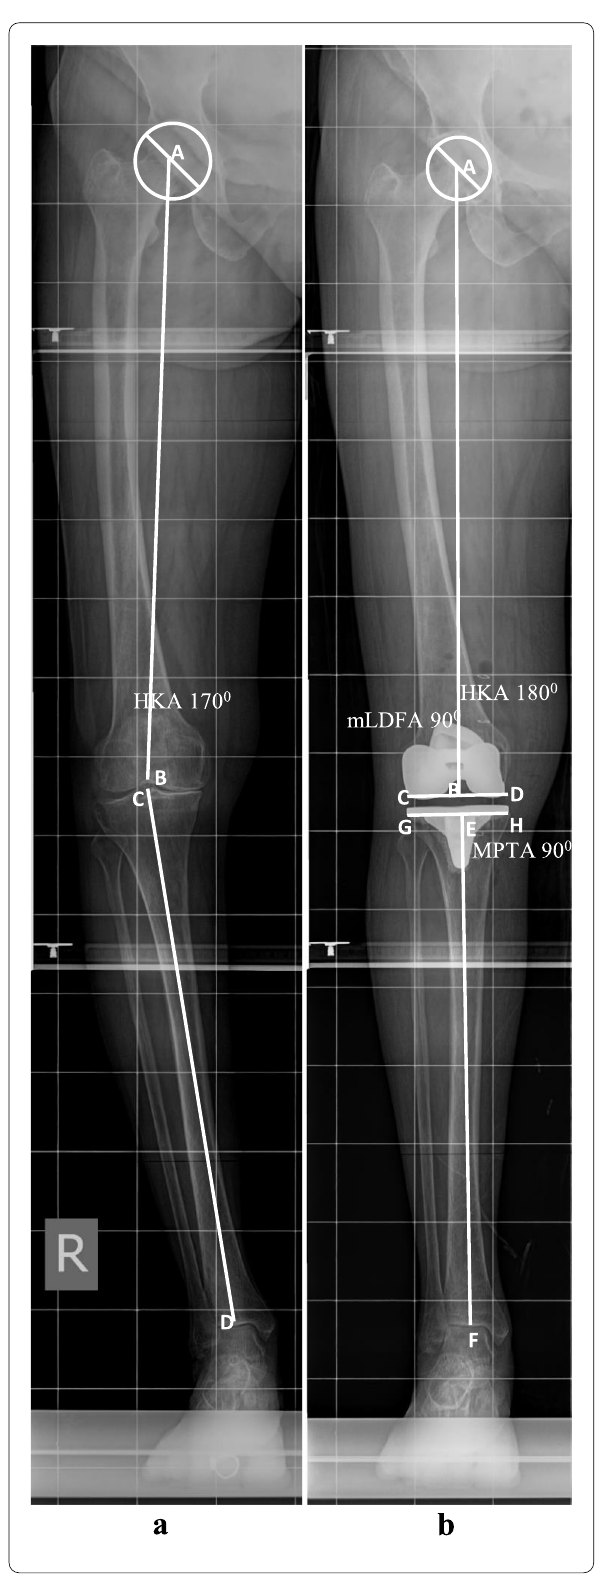
head (point A), centre of the distal femoral articular surface (point B), femoral mechanical axis (Line AB), centre of the proximal tibia/ centre of tibial spine (point C), centre of the distal tibial articular surface, coinciding with midtalar groove (point D), HKA angle i.e. angle between line AB and CD is 168 ° or 12 ° varus. b Postoperative standing LLR denoting HKA angle, (angle between line AB and EF) 180 ° , mLDFA, angle ABC, 90 ° and MPTA, angle FEH, 90